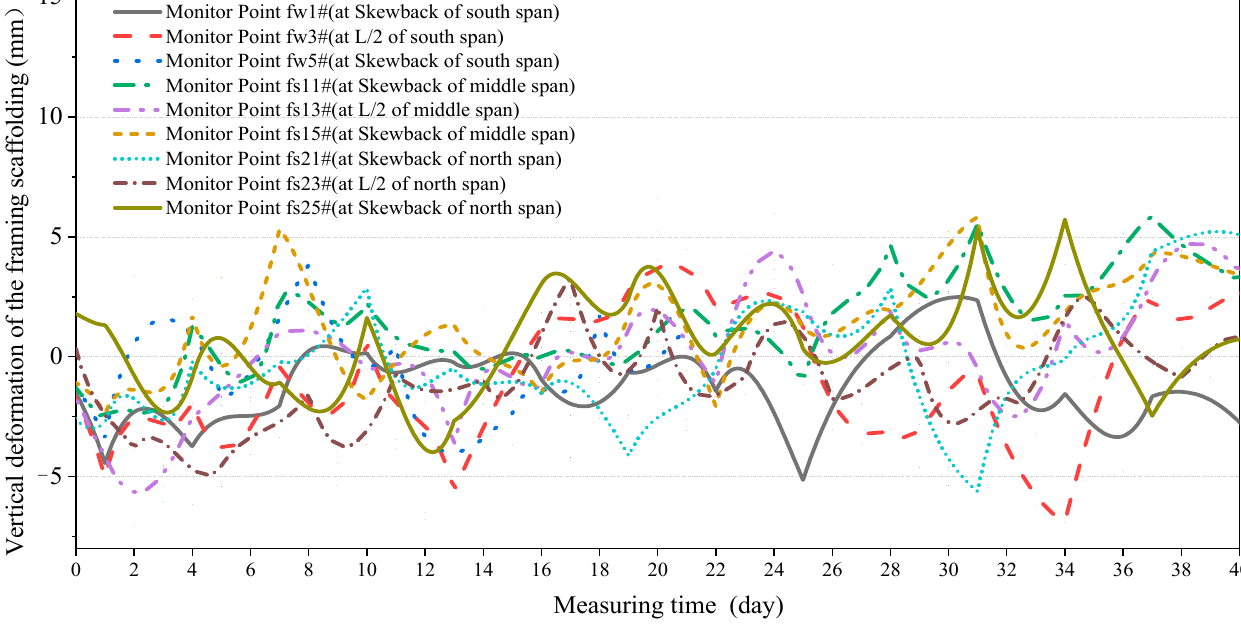
Figure 16. Assessment results during the demolish construction.